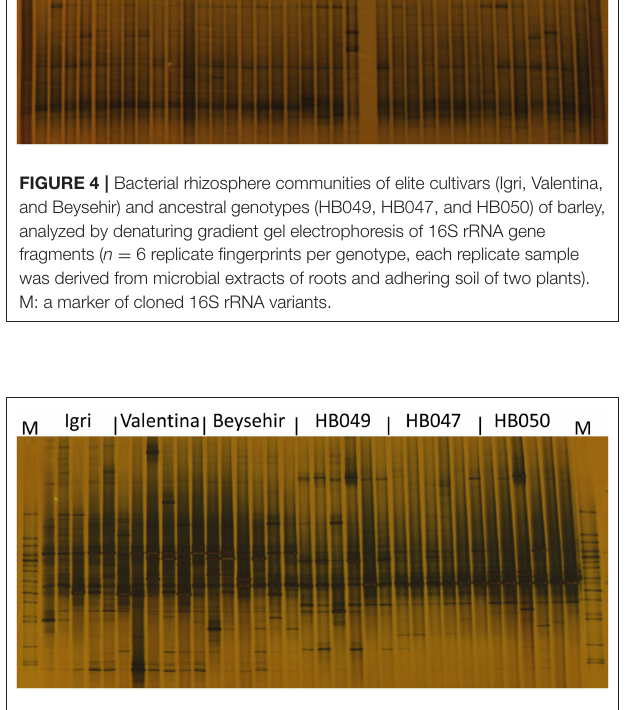
the ancestral genotypes, especially for EXPB1 , PR5 , and LOX2 (MANOVA, interaction microbiome ∗ elite_cv, Table 3 ).